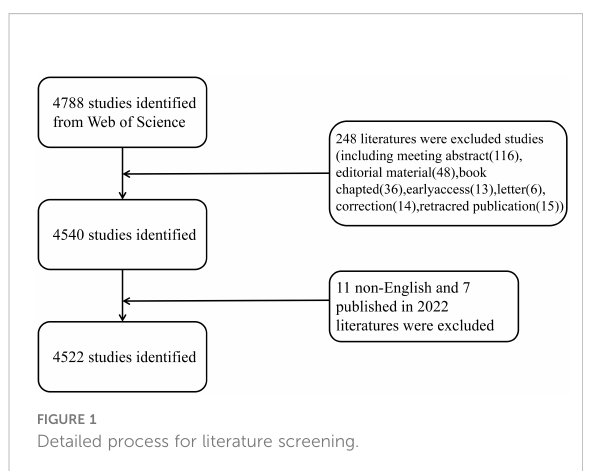
FIGURE 1 Detailed process for literature